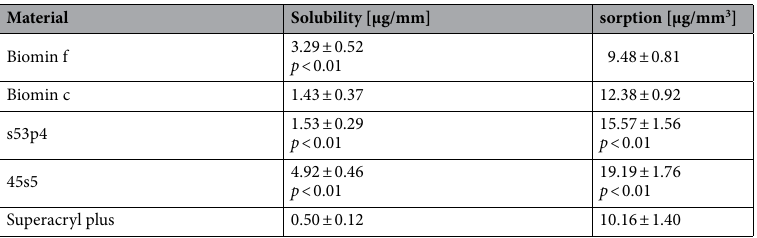
Table 3. Sorption and solubility [μg/mm 3 ] tested in distilled water for 7 days for four bioactive glasses and Superacryl Plus as the reference material. The solubility of all samples modified with bioactive glasses in relation to Superacryl Plus is statistically significant at the confidence level of p < 0.01. The sorption of acrylic samples modified with bioactive glasses in relation to the reference sample has a confidence level of p < 0.01 for 45S5 and